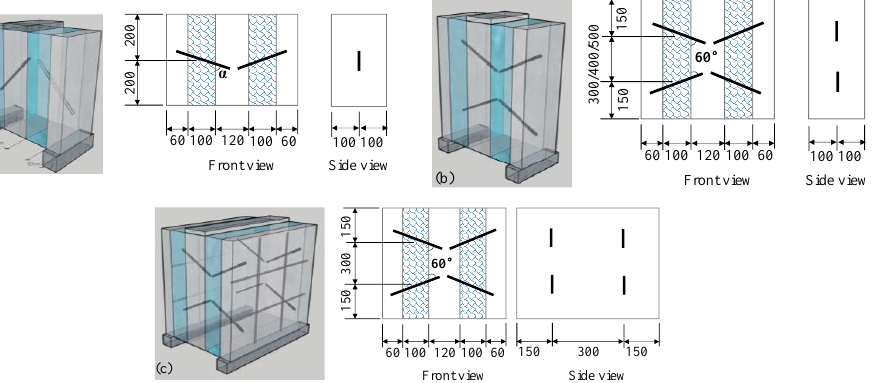
Figure 1. Schematic diagram of specimens ( a ) Double shear specimens; ( b ) ZS-1, ZS-2 or ZS-3; ( c ) ZS-4.